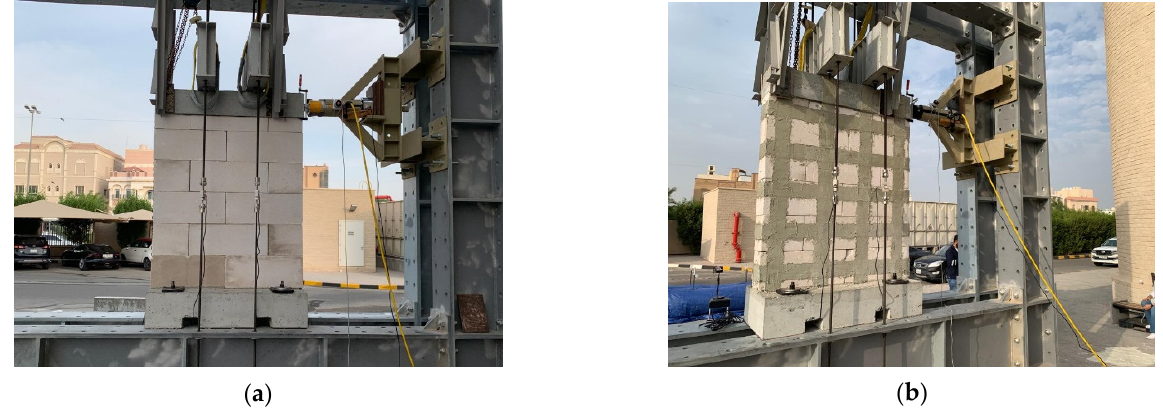
Figure 13. Walls prior to testing. ( a ) Unreinforced wall and ( b ) reinforced wall.